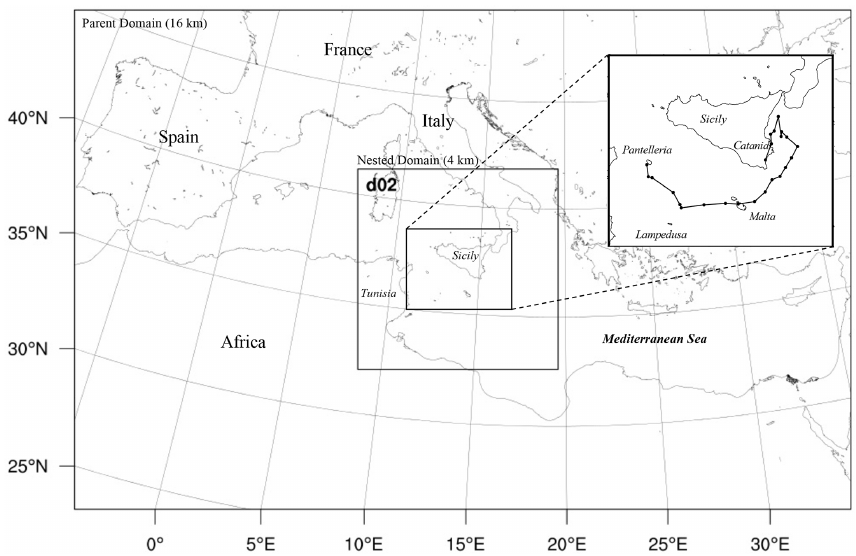
Figure 2. Numerical domain used for the multi-scale simulations performed in this study. The top-right embedded diagram shows the observed track of the medicane viewed from infrared satellite imagery.